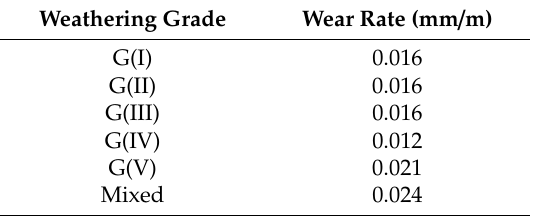
Table 5. Average wear rate per excavation distance for slurry discharge pipes.